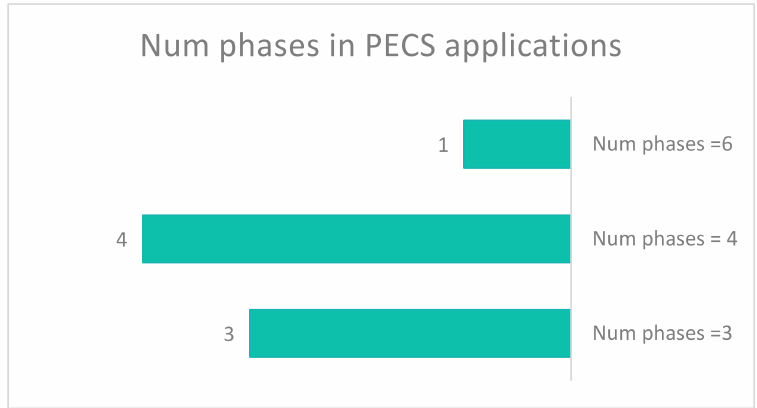
Figure 18. Num phases in PECS